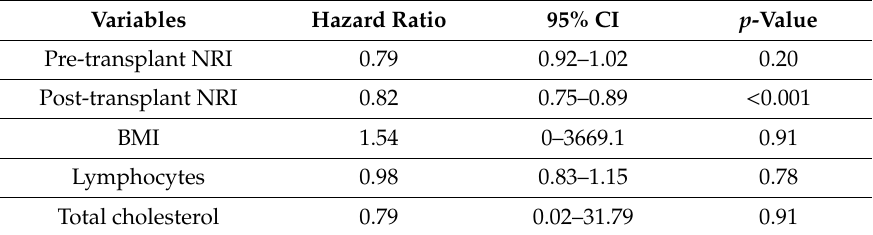
Table 4. Cox proportional hazards regression analysis of some characteristics of survival. Variables